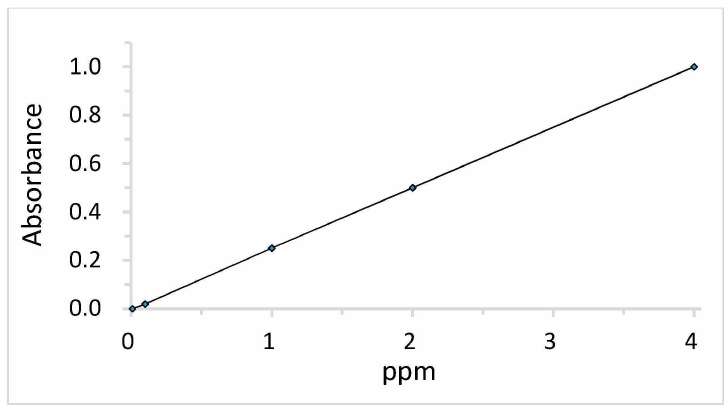
Figure 2. A plot of 3,3′,5,5′-Tetramethyl-4,4′diphenoquinone (DPQ) concentration (ppm) versus absorbance for determining wt % of DPQ .